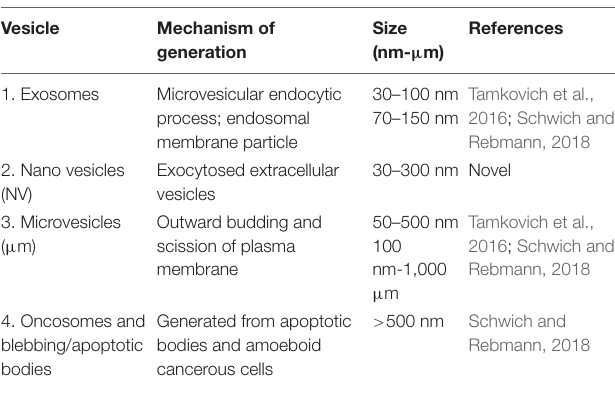
TABLE 1 | The four major categories of extracellular